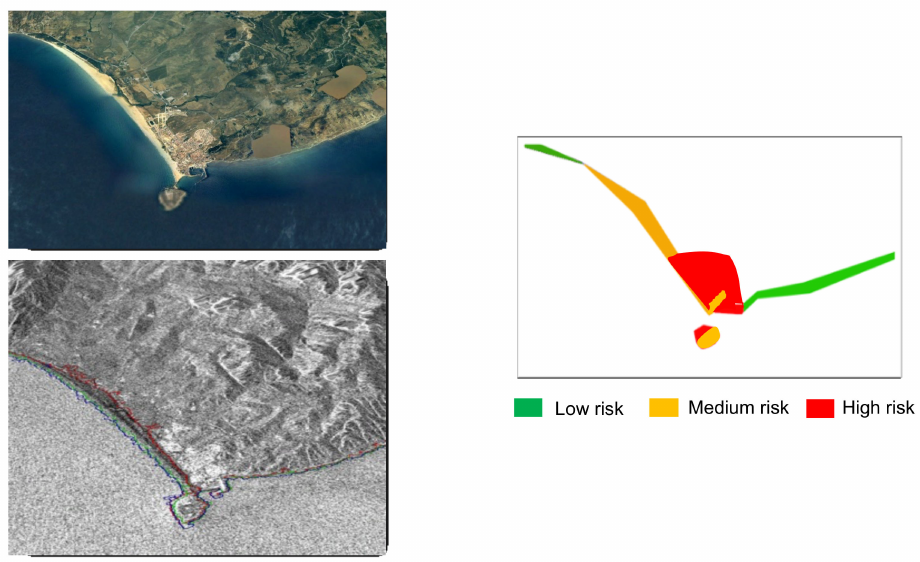
Figure 3. Shoreline and risk map obtained from a quad-polarimetric Radarsat-2 SAR image collected over the Gibraltar Strait. Top left: Google Earth© optical image; bottom left: shorelines extracted from r (red), see [5], Freeman–Durden model-based scattering components P S (green) and P V (blue), see [6], superimposed on the VV-polarized NRCS image; right: 3-class risk map generated from a decision-tree algorithm applied on the Freeman–Durden scattering